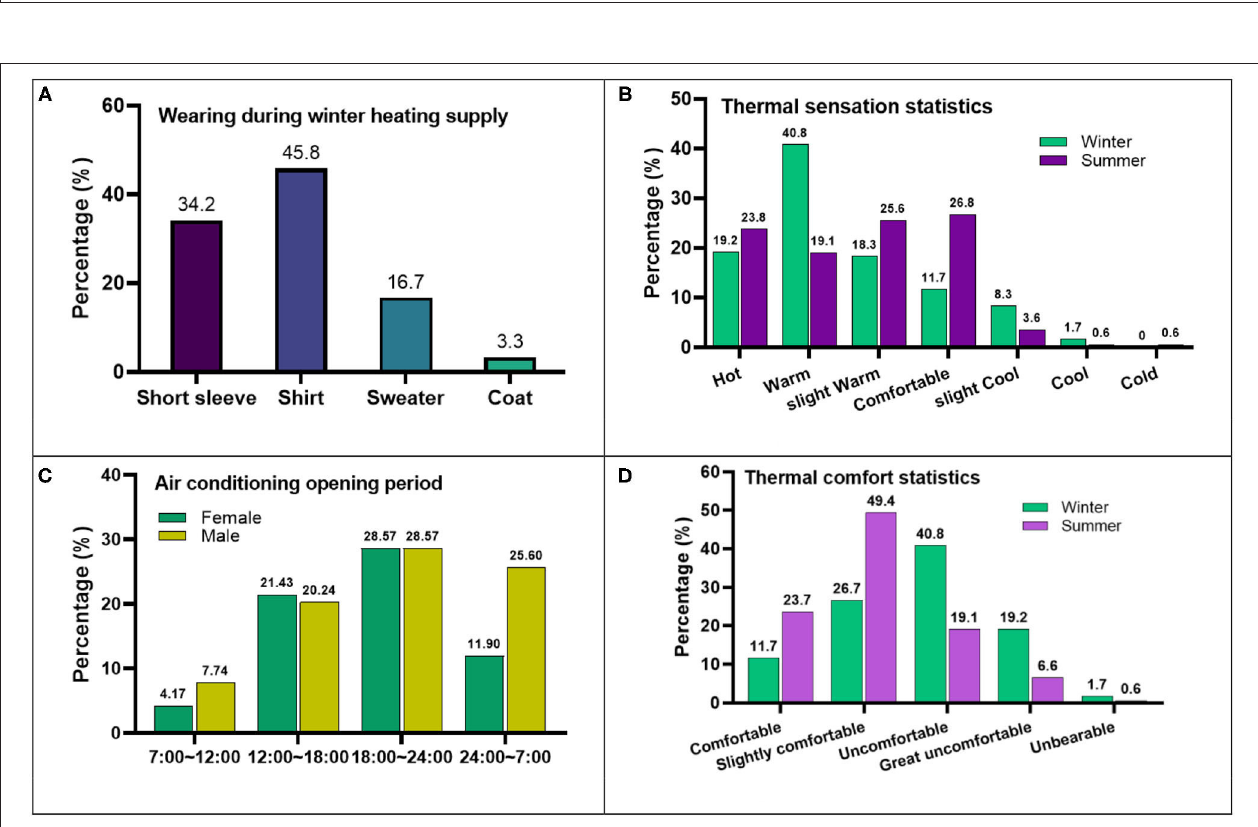
FIGURE 3 | Thermal environment survey results. (A) Wearing during winter heating supply. (B) Air conditioning opening period. (C) Thermal sensation statistics. (D) Thermal comfort statistics.